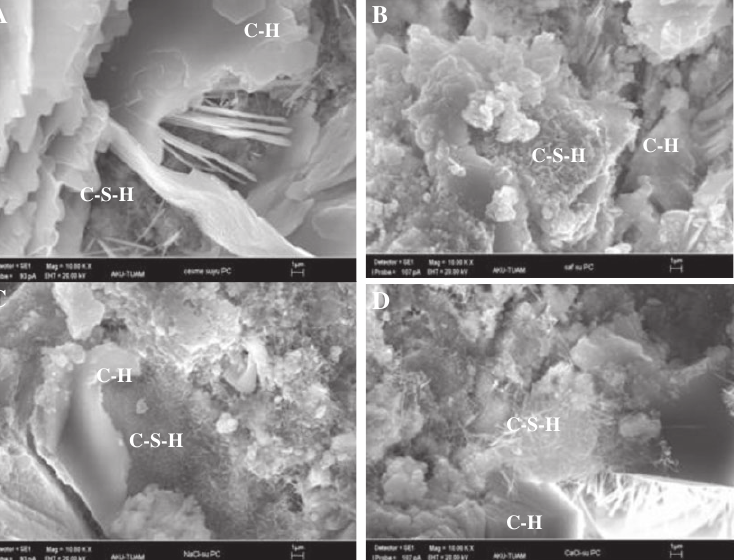
Figure 9 SEM image of cement pastes prepared with different types of mixing water (A: tap water; B: pure water; C: NaCl; D: CaCl